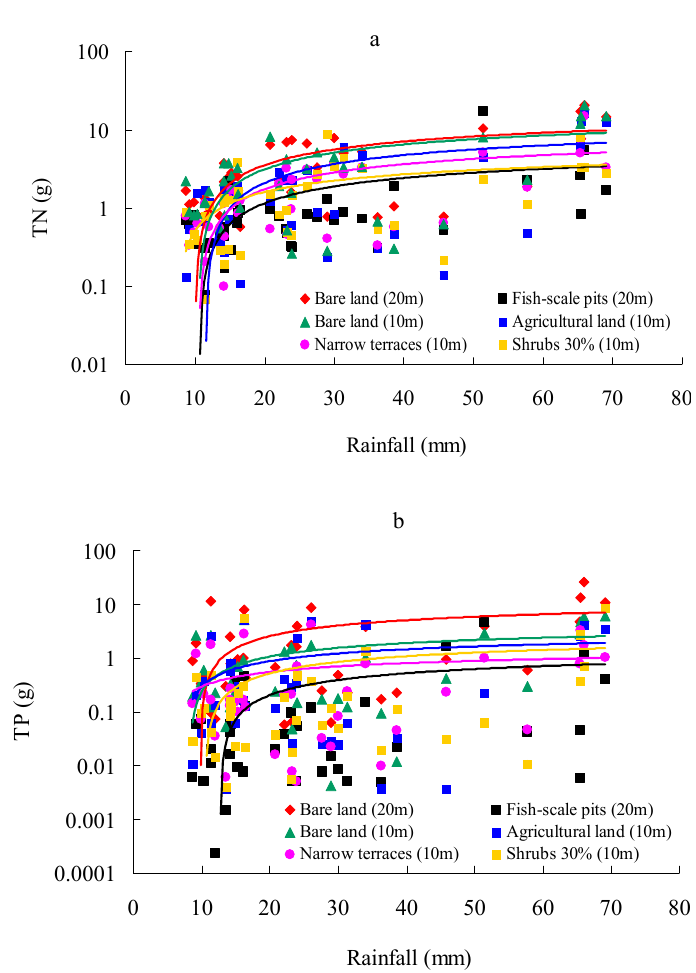
Figure 5. Relationship between total nitrogen and phosphorus losses and rainfall under different soil and water conservation practices; ( a ) relationship between total nitrogen (TN) loss and rainfall; ( b ) relationship between total phosphorous (TP) loss and rainfall.